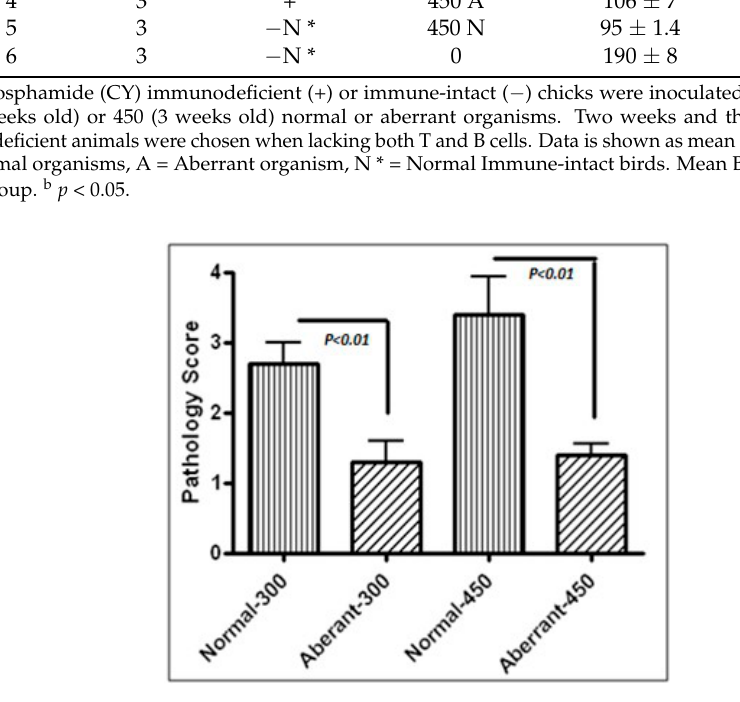
Figure 3. Pathological scores from Cylophosphamide (CY)-immunodeficient animals inoculated with 300 (at 2 weeks of age) or 450 (at 3 weeks of age) of either mature (sporulated) aberrant or normal organisms. Samples are collected 1 week after initiation of infection by oral gavage. Statistically significant pathological damages were detected in animals treated with normal organisms compared to aberrant forms ( p < 0.01). As expected no antibody production was detected in sera from these CY-immunodeficient animals.